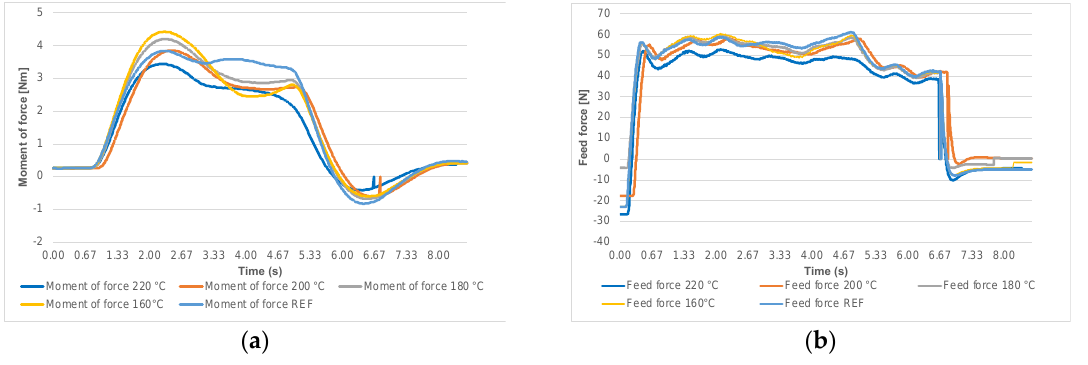
Figure 4. ( a )The moment of force for feed rate 10 m·min −1 ; ( b ) feed force for feed rate 10 m·min −1 .